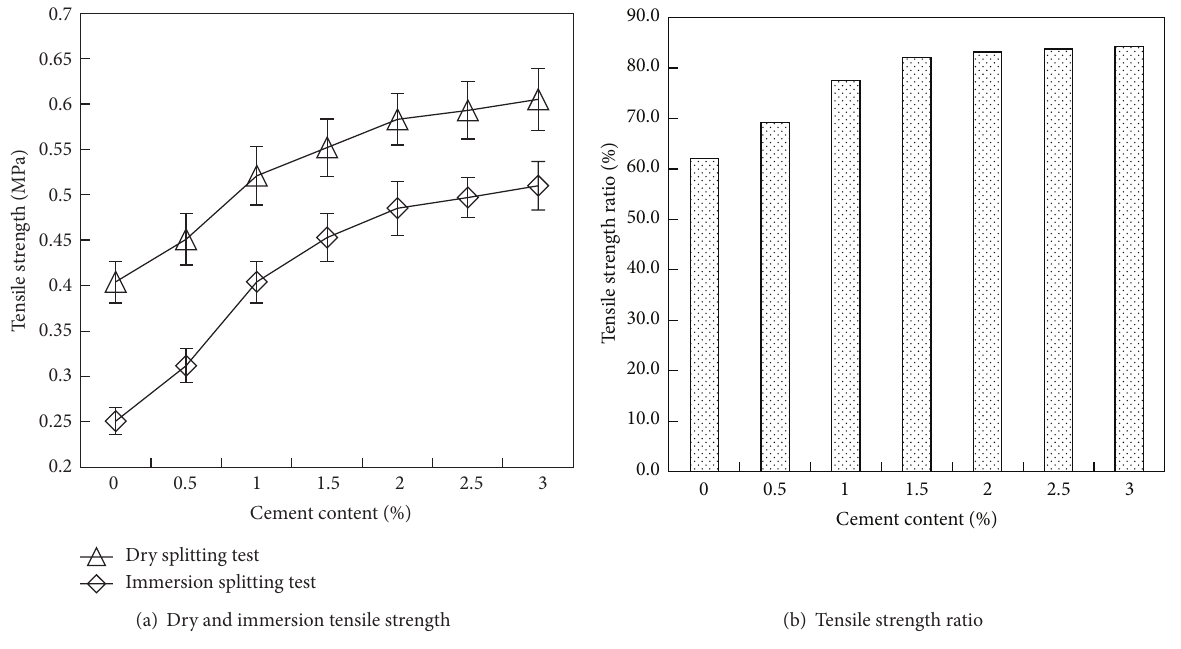
Figure 12: Tensile strength versus cement content for cold recycled asphalt